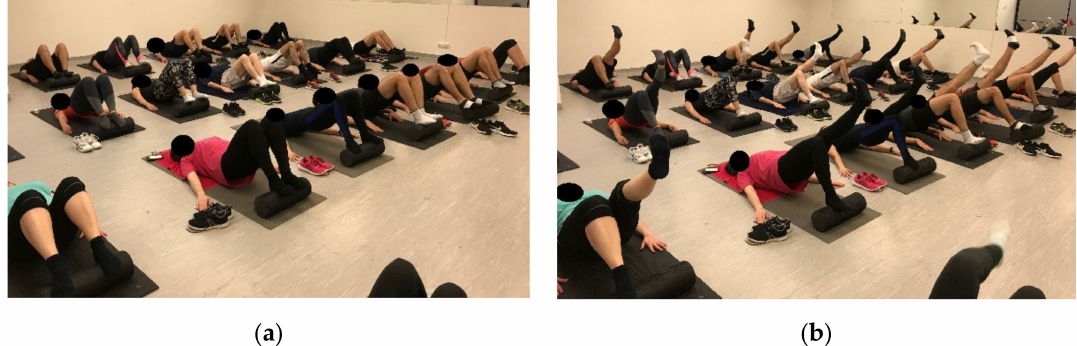
Figure 6. Segmental stabilization in unstable bilateral ( a ) and unilateral ( b ) supine